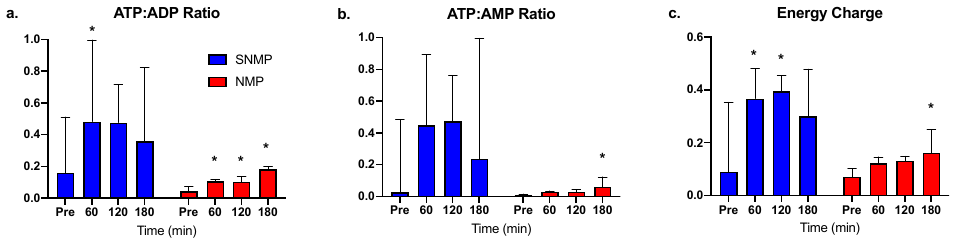
Figure 3. Energy cofactor changes during SNMP vs. NMP. ( a ) ATP:ADP, ( b ) ATP:AMP, and ( c ) energy charge ratios were quantitatively much higher in the SNMP group after initiation of perfusion, but with large variance. Livers undergoing NMP demonstrate a consistent increase in energy cofactor, though absolute values were lower compared to SNMP indicating the more active metabolic state at physiologic temperatures. * indicates p < 0.05 for the random intercept mixed model. Abbreviations: ATP, adenosine triphosphate; ADP, adenosine diphosphate; AMP, adenosine monophosphate; SNMP, subnormothermic machine perfusion; NMP, normothermic machine perfusion.